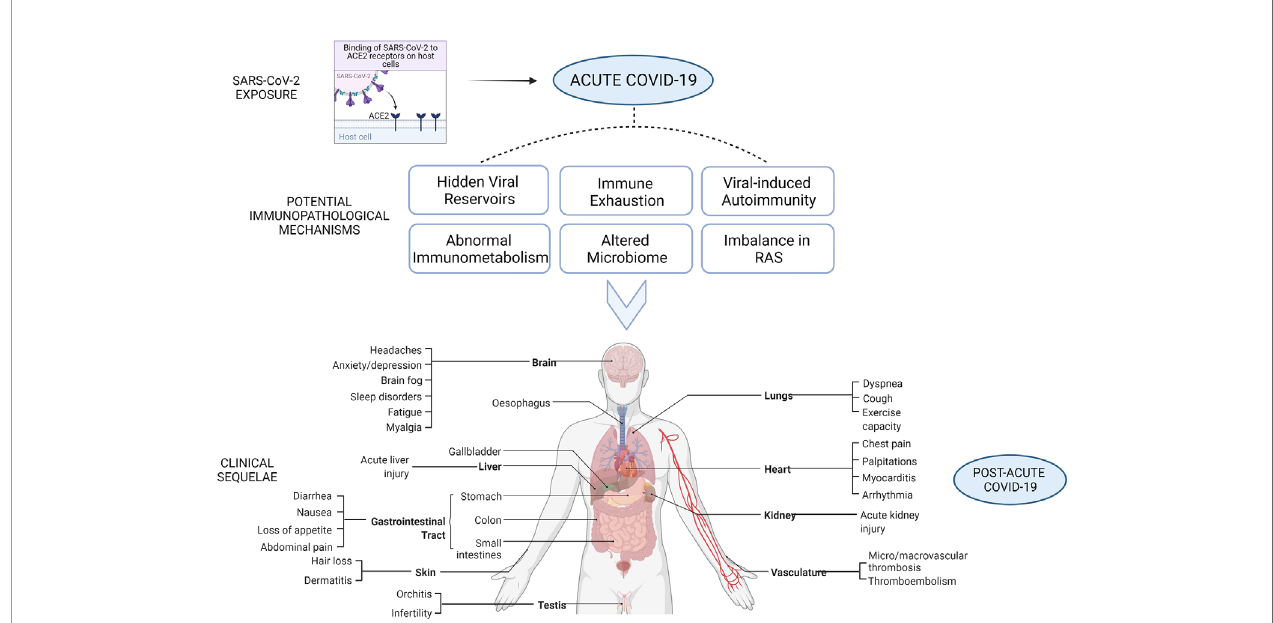
FIGURE 2 | Potential immunopathological mechanims underlying multi-organ sequelae of post-acute sequelae of COVID-19